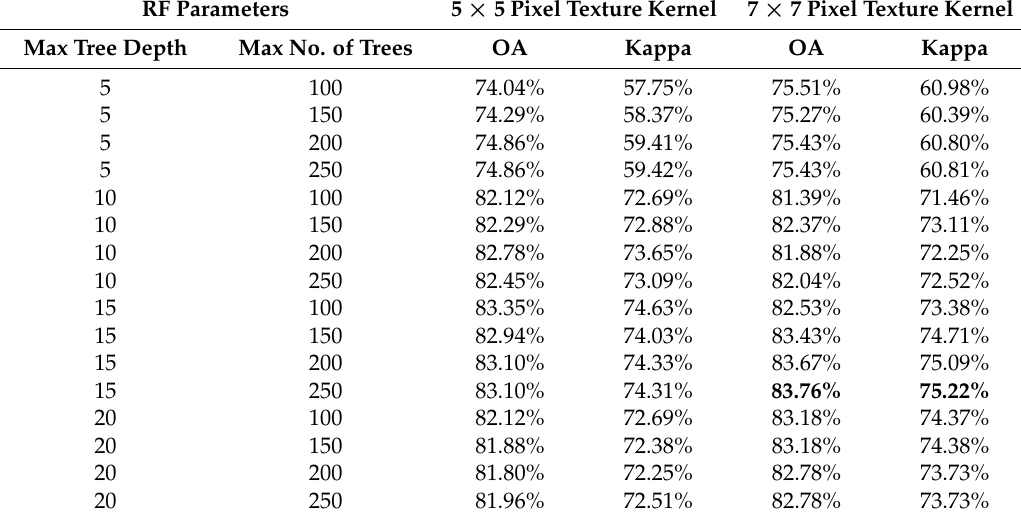
Table 3. Automated classification performance for submerged features across all five study sites under varying random forest (RF) parameter values and texture kernel sizes, with the top classification bolded . OA = overall